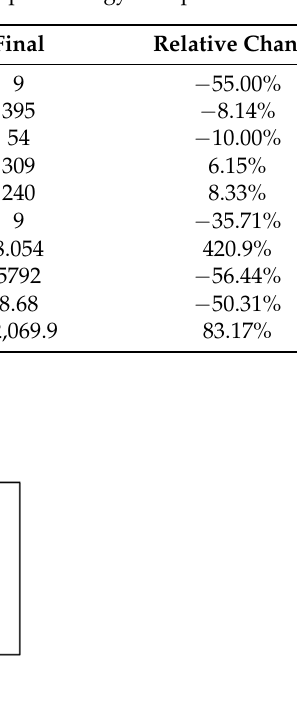
Table 4. Geometric and performance parameters of initial and optimized gyroscope.